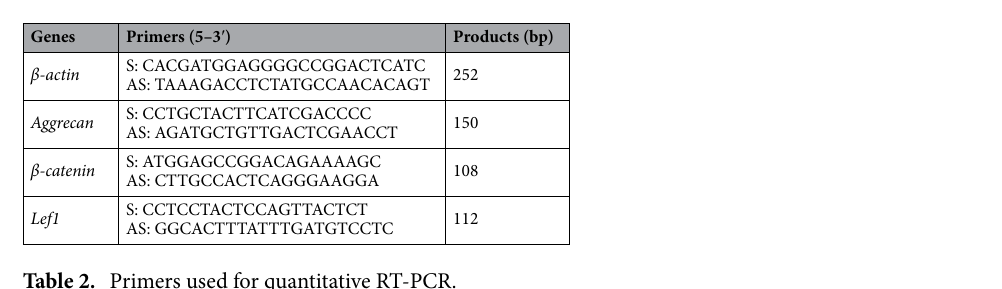
Table 2. Primers used for quantitative